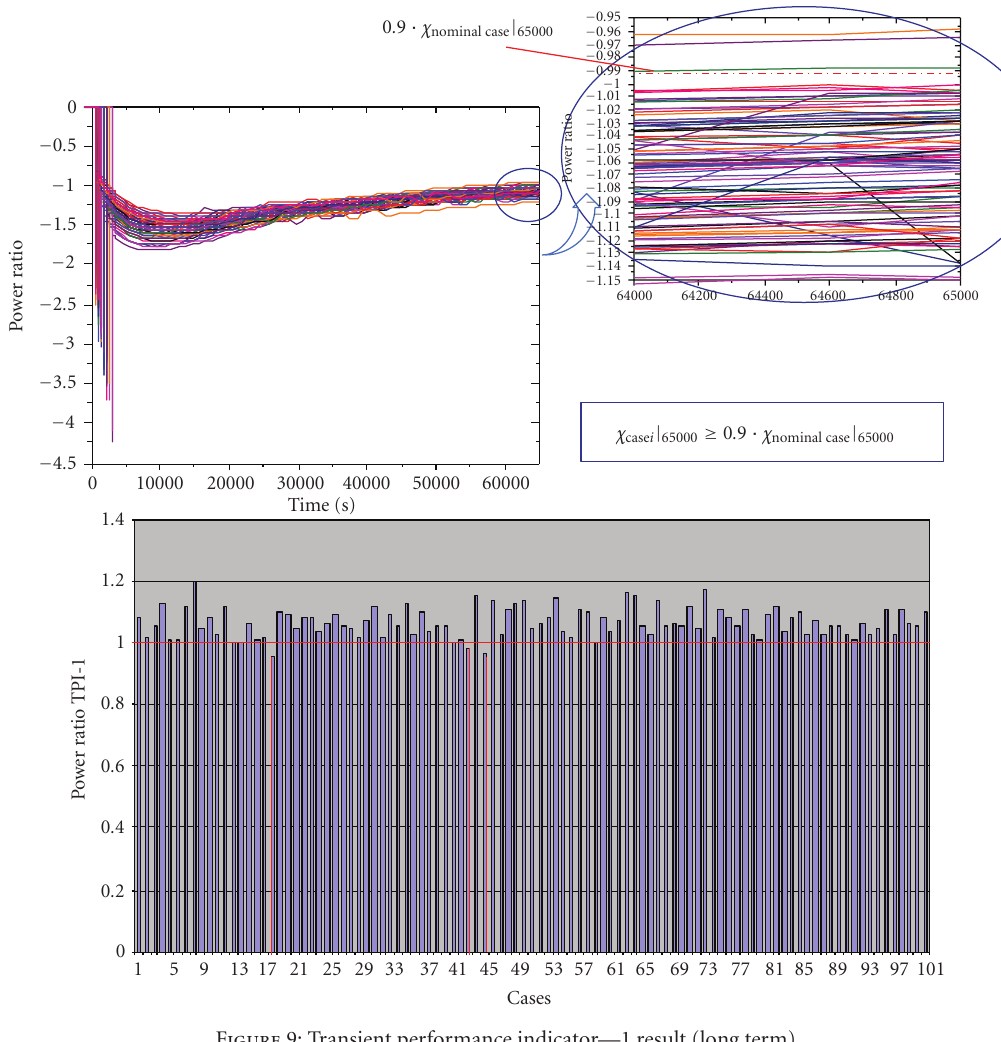
Figure 9: Transient performance indicator—1 result (long term).